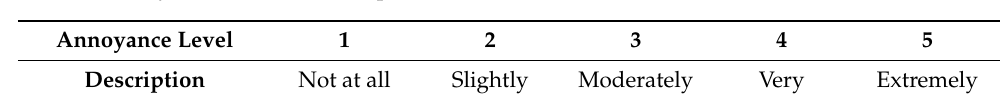
Table 1. Annoyance level and